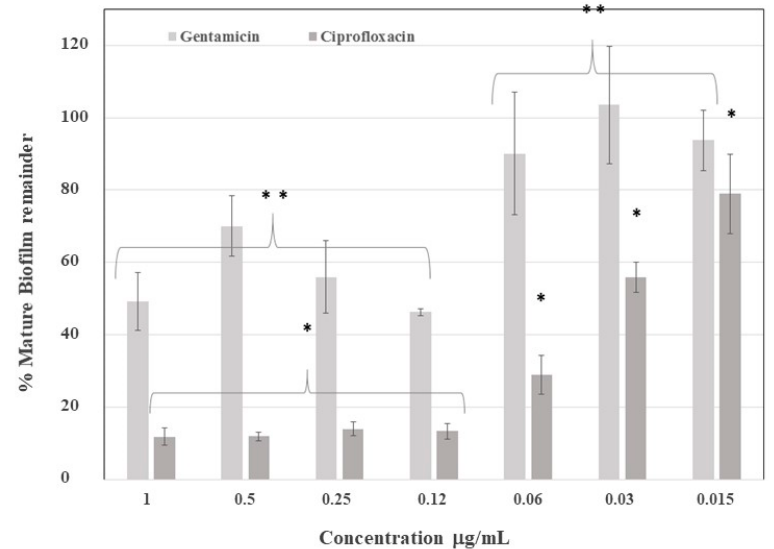
Figure 3. Mature biofilm elimination after application of antibiotics. Gentamicin eliminated 50% of the mature biofilm at between 0.12 and 1.0 µg/mL, while ciprofloxacin eliminated 50% of the mature biofilm at 0.03 µg/mL. Calculated values are in respect to the control group mean. ** Statistically significant difference between groups for gentamicin. * Statistically significant difference between groups for ciprofloxacin.